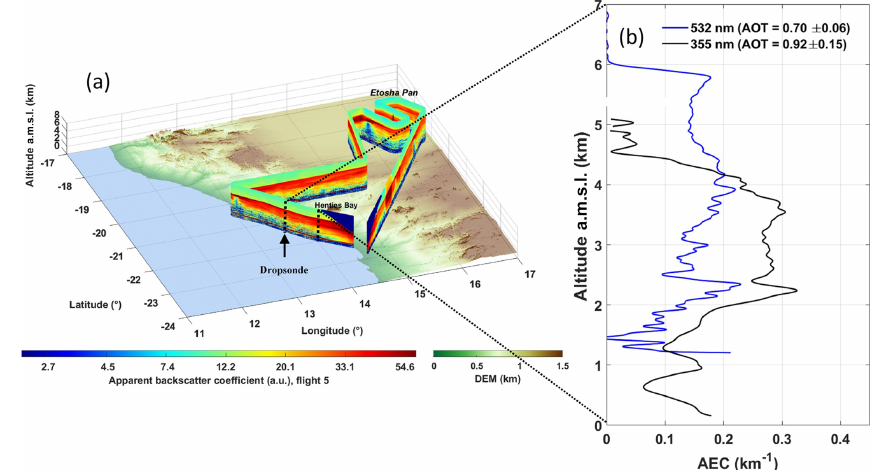
Figure 8. (a) Distance–height (“curtain-like”) evolution of the LNG-derived apparent backscatter coefficient at 532nm below the SAFIRE Falcon 20 during the morning flight on 5 September 2017. The location of the dropsonde released over the ocean is indicated as well as the location of the averaged LNG AEC profile shown in panel (b) (between the two dotted vertical lines). (b) Vertical profiles of the AEC derived from the airborne lidar at 532nm ( ∼ 10:00UTC; solid blue line) and from the ground-based lidar at 355nm ( ∼ 14:00–15:00UTC; solid black line).